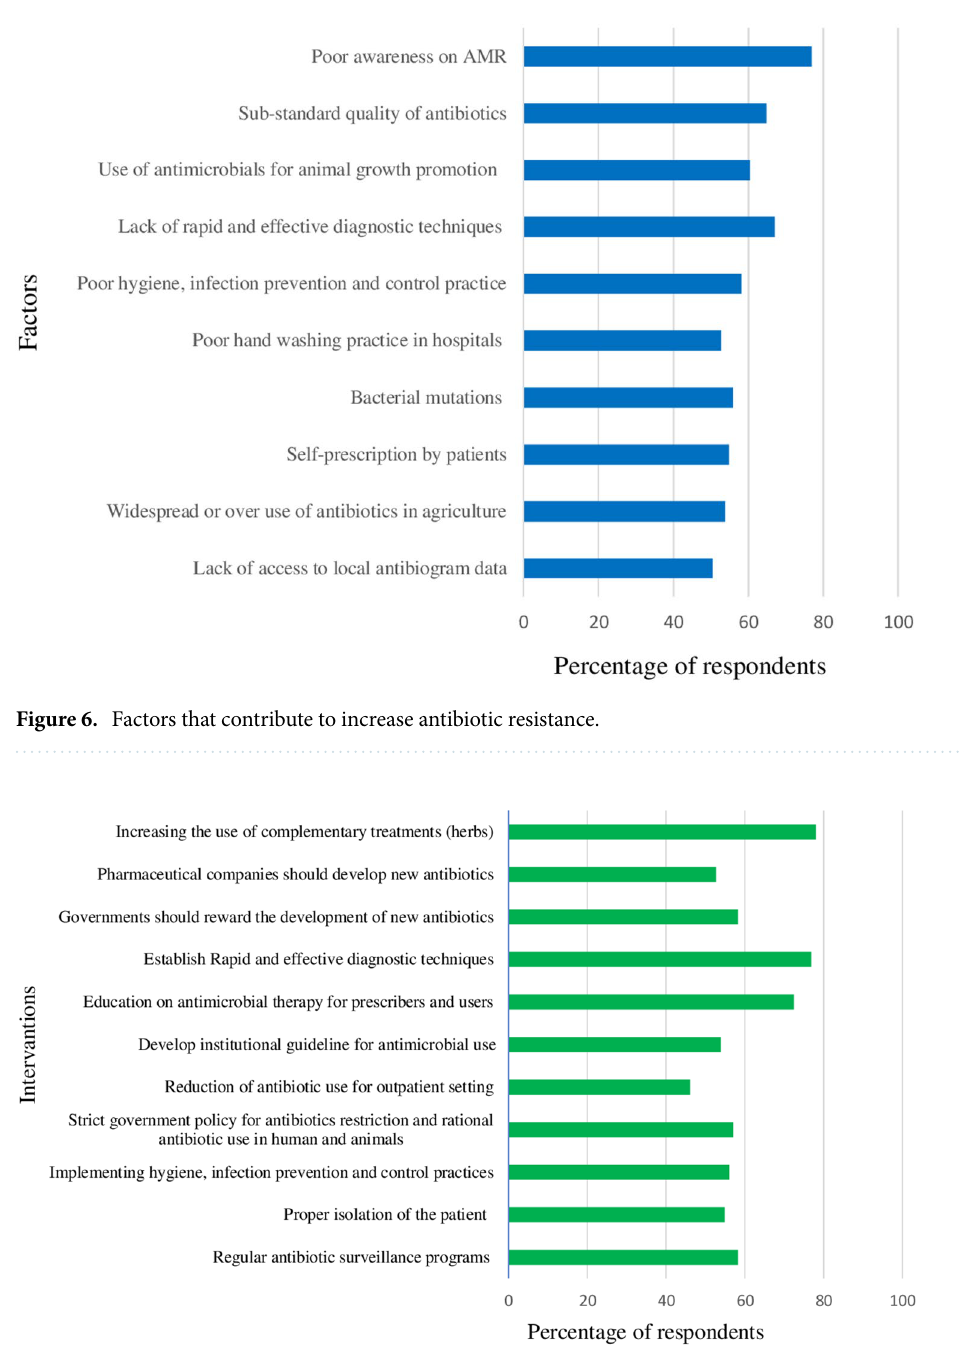
Figure 7. Interventions that contribute to reduce antibiotic use and